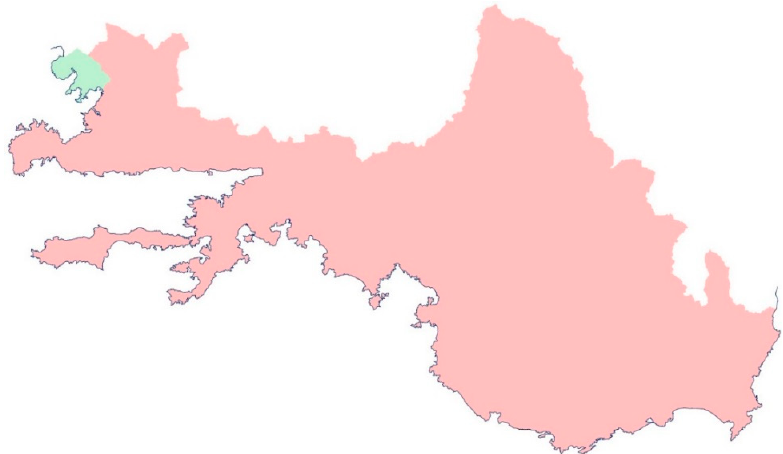
Figure 11. The missed first-level sub-basin (green).